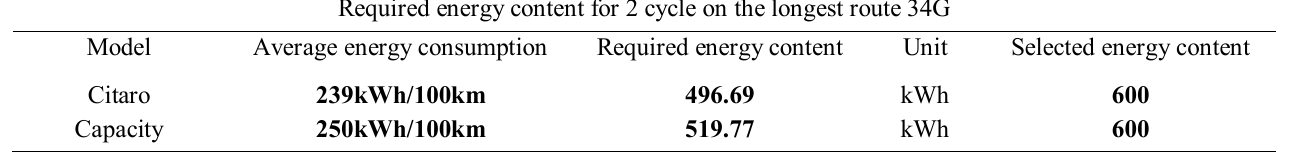
REQUIRED ENERGY VALUES FOR E-BUSES Required energy content for 2 cycle on the longest route 34G